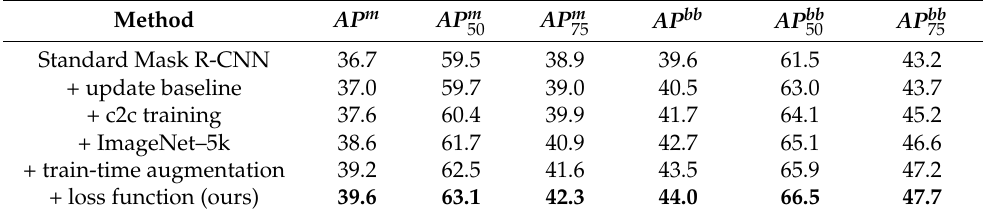
Table 4. Comparison of the improved results of the classification loss with some enhancement results of Mask R-CNN on COCO minival . All the results use ResNet-101 as the backbone. Each row adds an extra component to the above row. The Mask R-CNN results are from Table 8 in the Appendix of